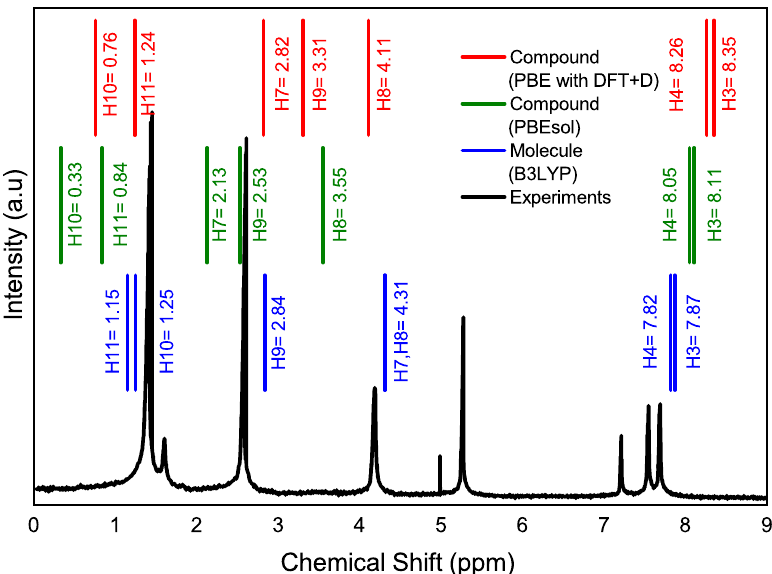
Figure 4. Intensity as a function of the chemical shift. The panels compare the experimental nuclear magnetic resonance in (black line) with different functionalities and in different situations. PBE with DFT+D in CASTEP (red line) and PBEsol in CASTEP (green line) are applied to the solid of the C 10 H 13 BO 3 S compound, and B3LYP in Gaussian (blue line) is applied on the molecule of the C 10 H 13 BO 3 S compound. Note that the value of 5.27 ppm that appears in the experimental resonance is the one corresponding to the one impurity.